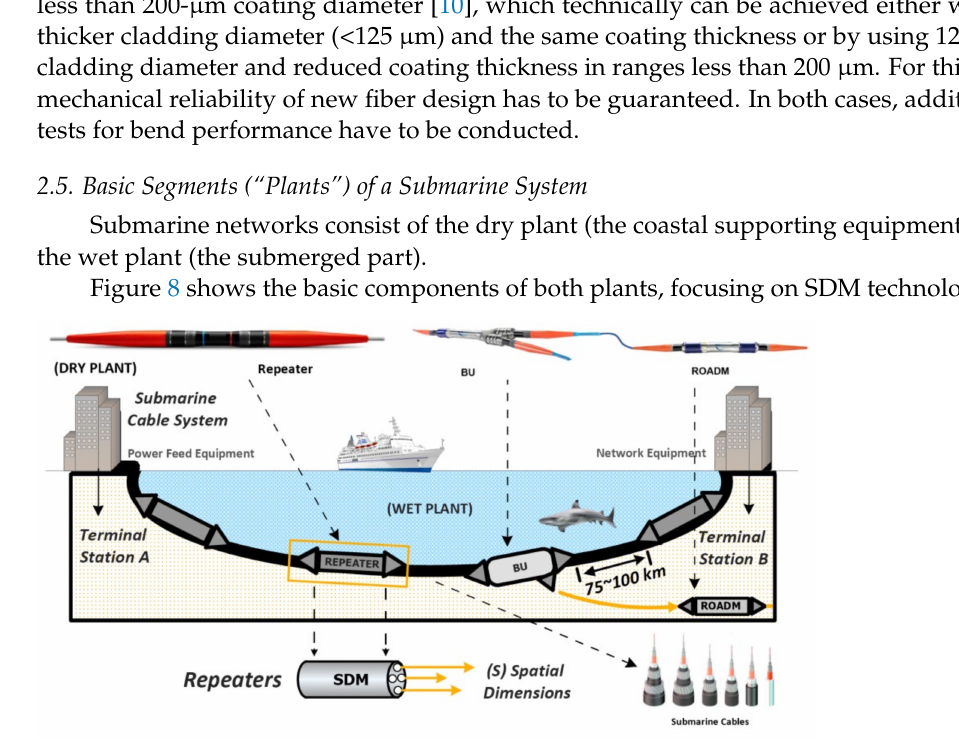
Figure 8. A typical submarine cable system takes into account all network elements and state-of-the- art SDM repeaters (analytically described